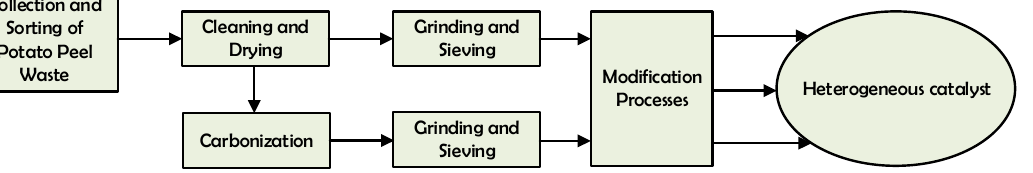
Figure 7. Flowchart for the proposed procedure for the development of catalyst from PPW.